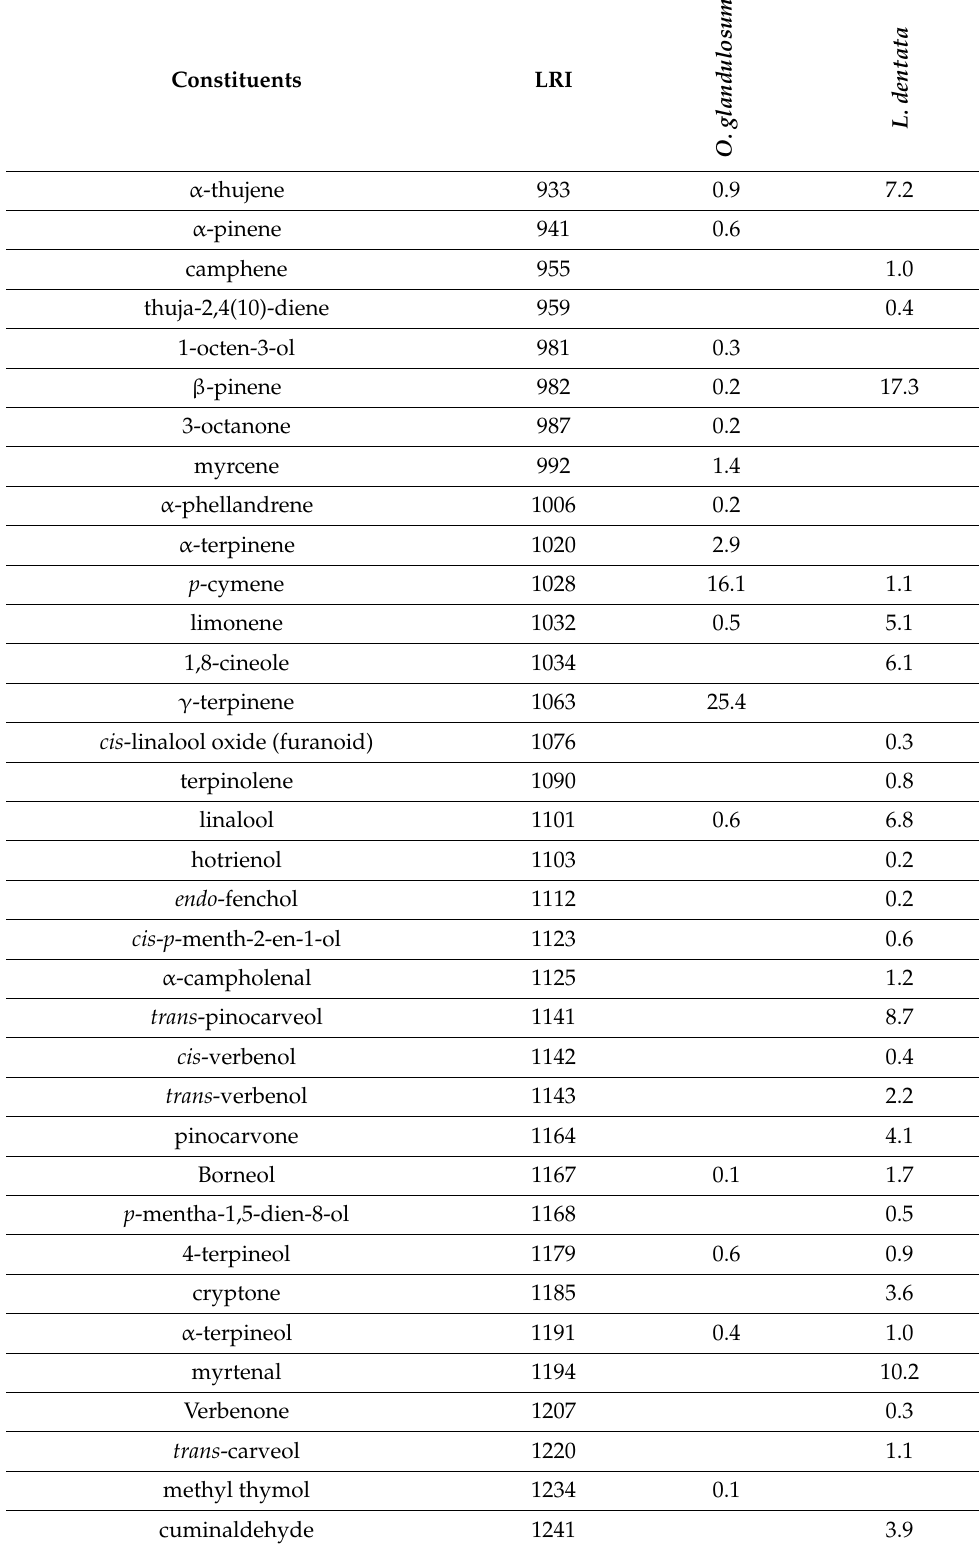
Table 1. Chemical composition of the essential oils from O. glandulosum and L. dentata